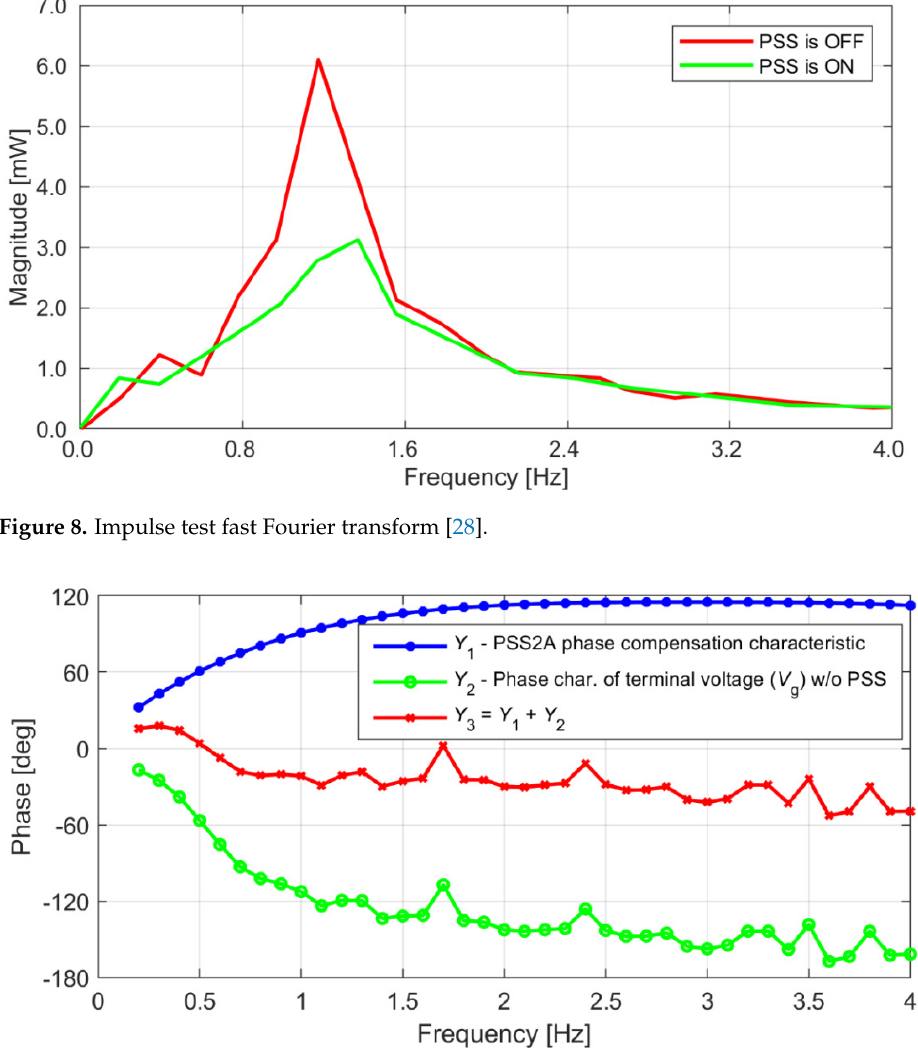
Figure 9. PSS phase characteristics [40] (phase compensation: T 2 = T 4 = 0.02 s, T 1 = T 3 = 0.20 s).